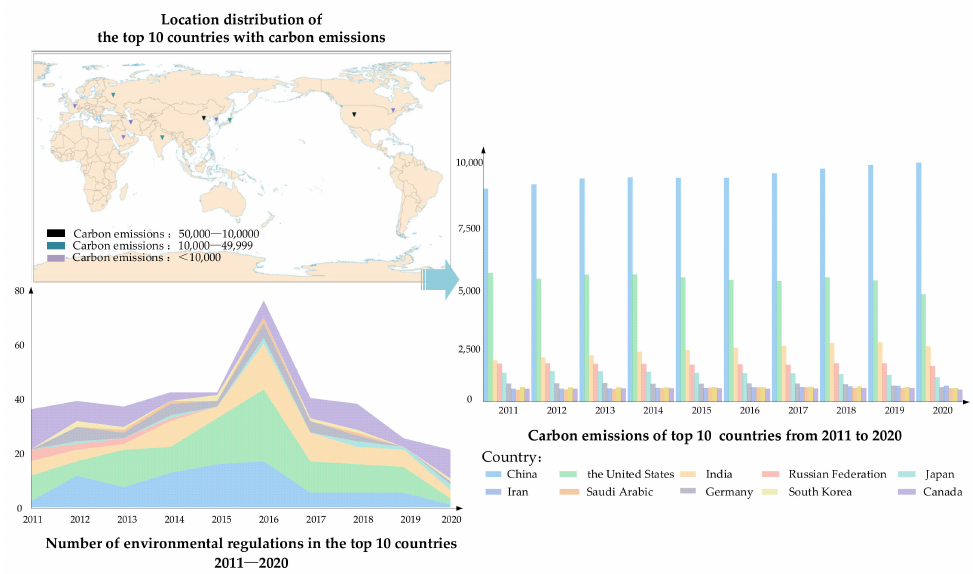
Figure 1. Carbon emissions and environmental